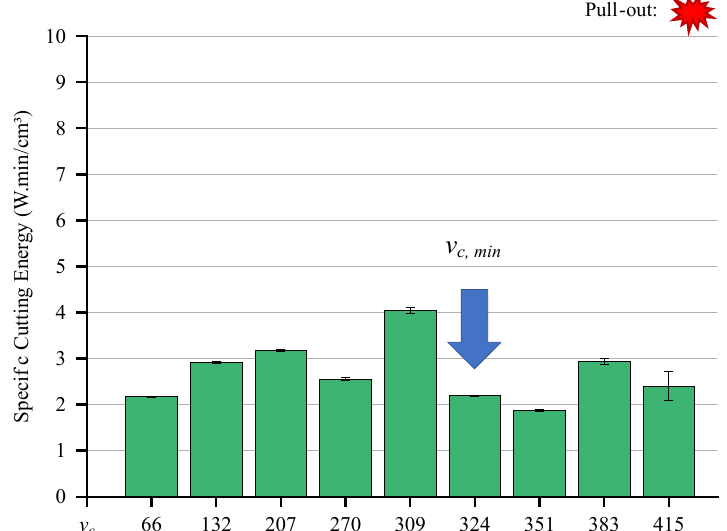
Figure 17. Determination of the minimal cutting speed of the thermoplastic tool, the evolution of the specific cutting energy (W · min/cm 3 ) for different v c (m/min) with f z = 0.030 mm/tooth, a p = 3 mm, and a e = 0.5 mm. No material pull-out was